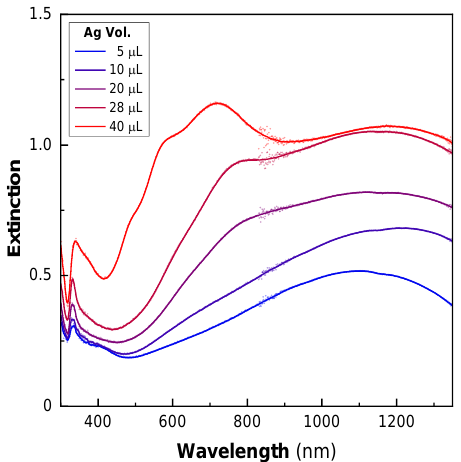
Figure 3. Optical properties during the formation of ultrathin silver nanoshells. The UV–Vis–NIR spectra of 200-nanometer silica particles after the shell-growth step using increasing volumes of silver (5–40 µL).